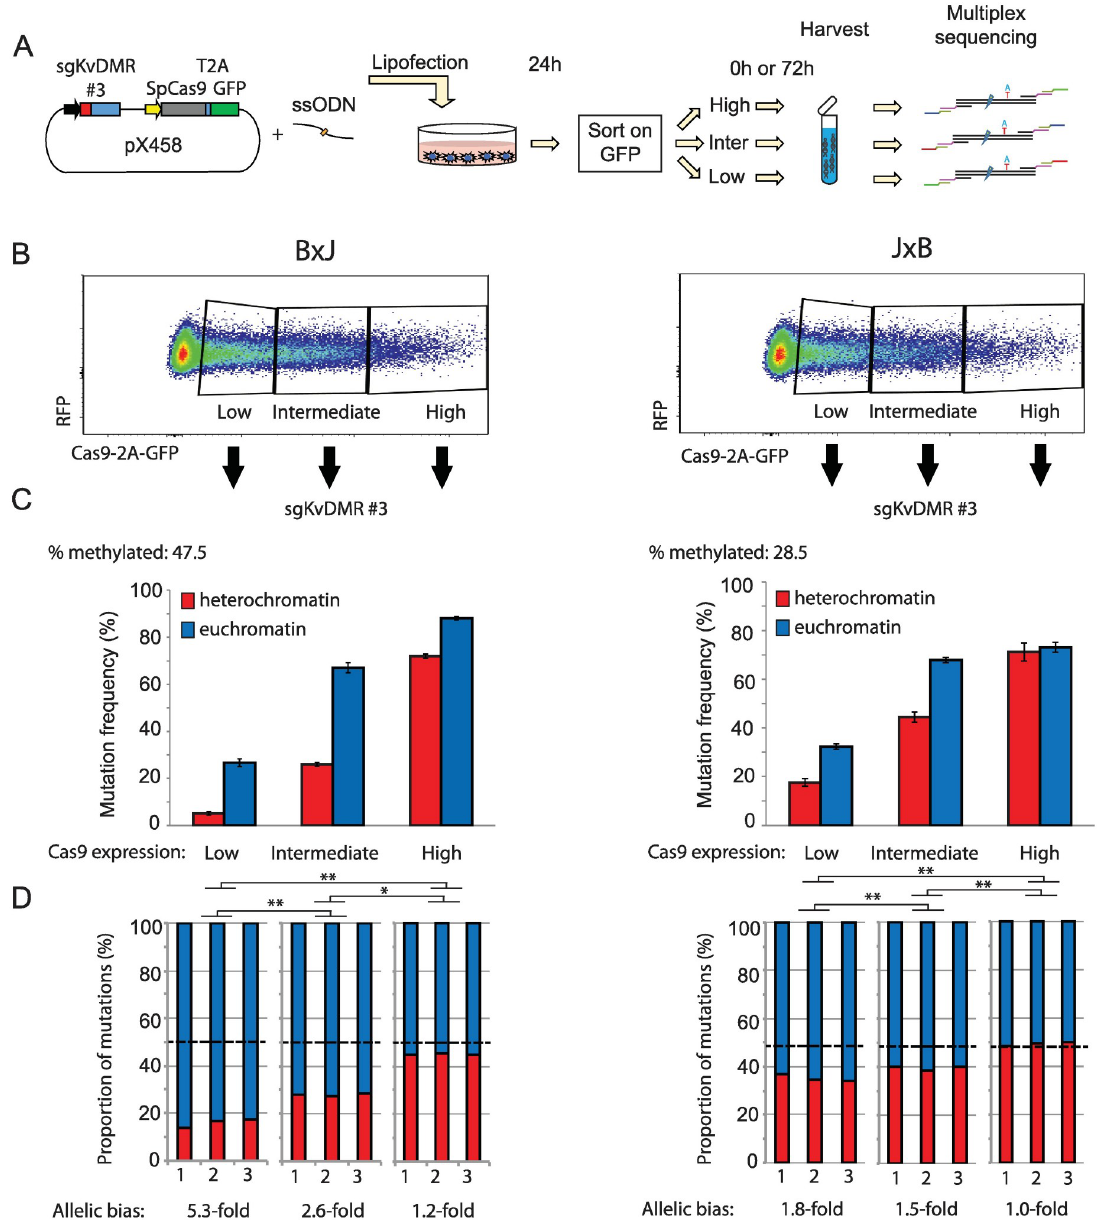
Fig 4. Heterochromatin impedes genome editing in a Cas9-concentration–dependent manner. (A) Schematic outlining the experimental workflow. After FACS, cells were either harvested immediately (S4 Fig) or cultured for an additional 72 hours (this figure). (B) Flow cytometry profiles show widely variable expression of Cas9-2A-eGFP at 24 hours following transfection with guide gKvDMR#3 expressed from pX458 (see panel A). (C) Allele-specific mutation analysis within cell populations expressing different levels of Cas9, FACS purified 24 hours post transfection using the gating scheme in panel B and then cultured for an additional 72 hours before harvesting. Allelic differences are less pronounced in J × B cells due to partial loss of imprinted heterochromatin on maternal alleles in this cell line. Error bars represent SD of three biological replicates. (D) Stacked histograms show the allelic mutation bias in each experiment. The percentage of methylated strands was measured in mock-transfected cells without selection for Cas9 expression level. One-way ANOVA was conducted using fold-difference between mutation frequencies on maternal versus paternal alleles, to assess whether this was affected by Cas9 expression level. Significant differences were found in both cell lines ( p < 0.001). Asterisks denote p -values for Tukey’s HSD test on the specified pairwise comparisons. � p < 0.05, �� p < 0.01. Quantitative data underlying panels C and D are provided in S1 Data, and details of MiSeq libraries including SRA accessions are provided in S2 Data. Cas9, CRISPR-associated protein 9; eGFP, enhanced green fluorescent protein; FACS, fluorescence-activated cell sorting; GFP, green fluorescent protein; HSD, honest significant difference; RFP, red fluorescent protein; SRA, Sequence Read Archive; ssODN, single-stranded oligodeoxynucleotide.